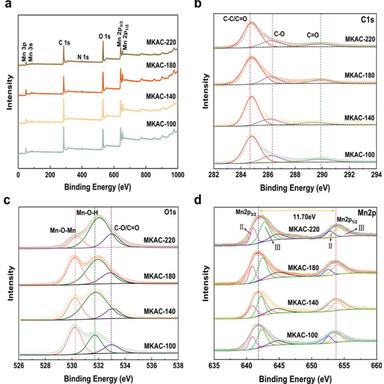
(a) XPS survey spectra, (b) C1s spectra, (c) O1s spectra and (d) Mn2p spectra of the MKAC-T materials prepared by four different solvothermal temperature.